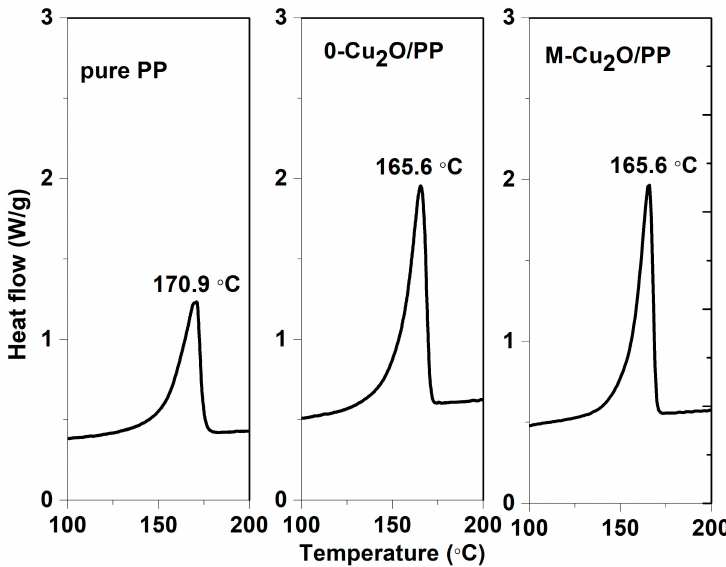
Figure 9. Melting curves for pure PP and Cu 2 O / PP